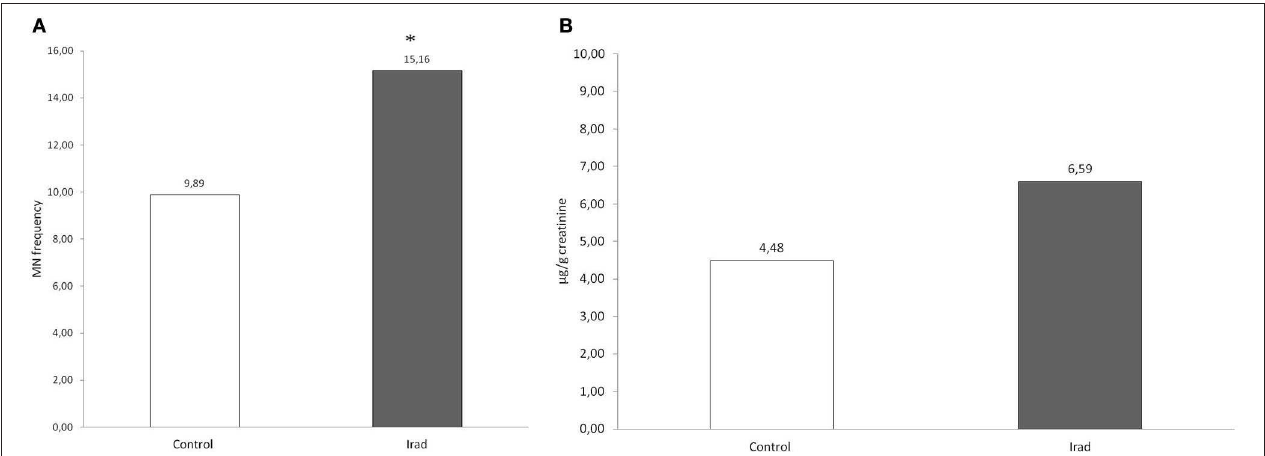
FIGURE 1 | Micronucleus frequency (A) and 8-OHdG values (B) in hospital workers exposed to ionizing irradiation. 8-OHdG, 8-hydroxy-2 ′ -deoxyguanosine value; Control, unexposed healthy voluntairs; Irad, hospital workers exposed to